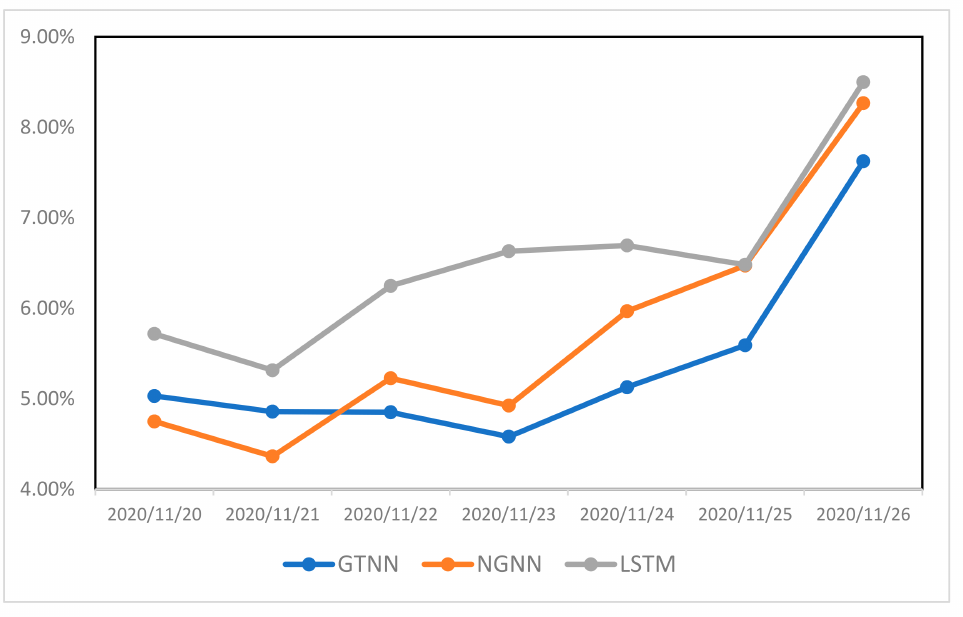
Figure 6. sMAPE for GTNN, NGNN, and baseline LSTM models over seven days as